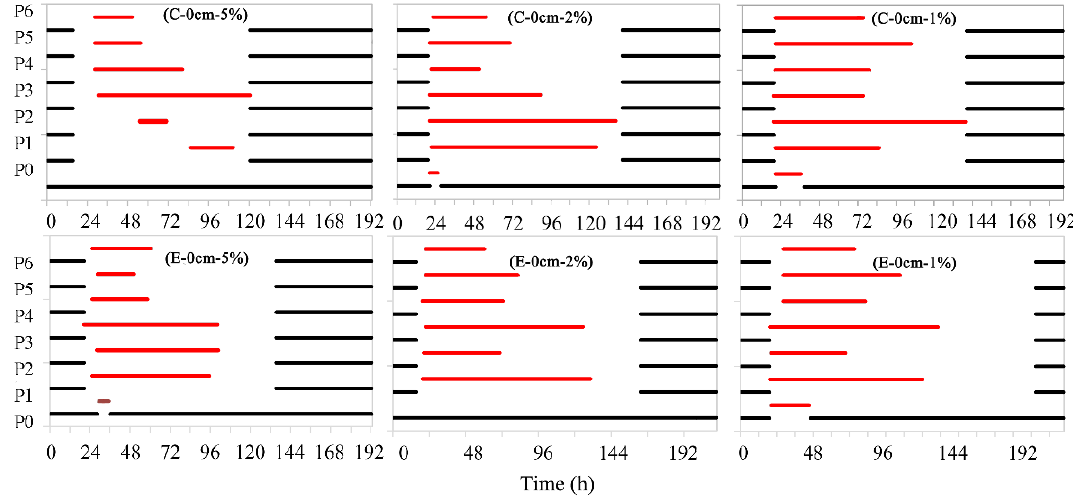
Figure 8. Scheduling schemes under different frequency rainfall conditions in the current and extreme climate scenario. Black represents the gate and red represents the pump. Serial number of pump